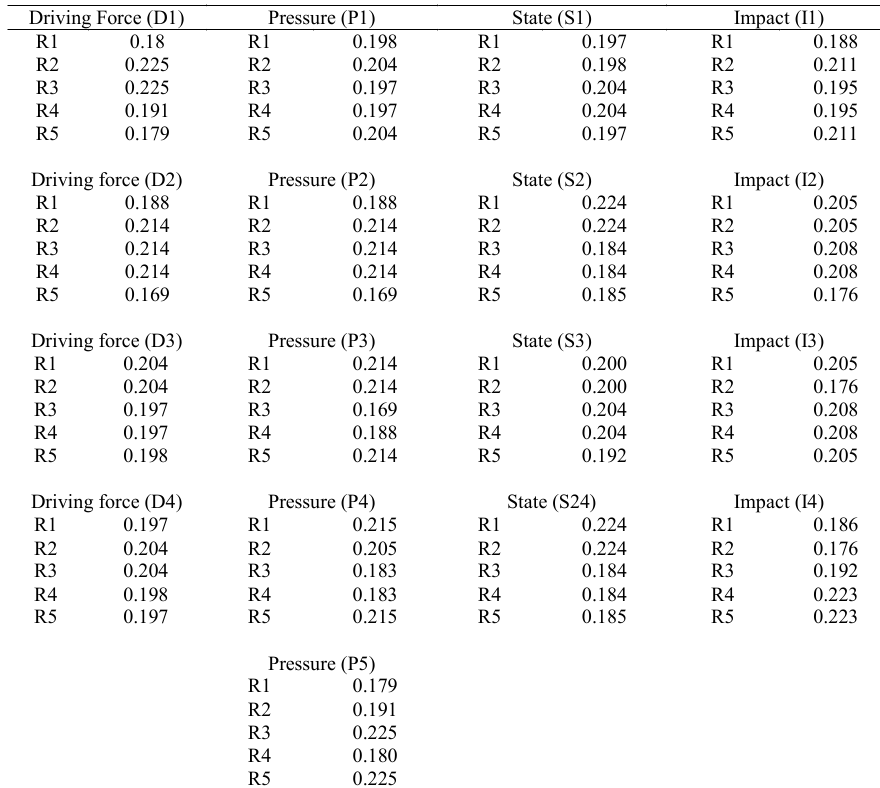
Table 2: FAHP final weights